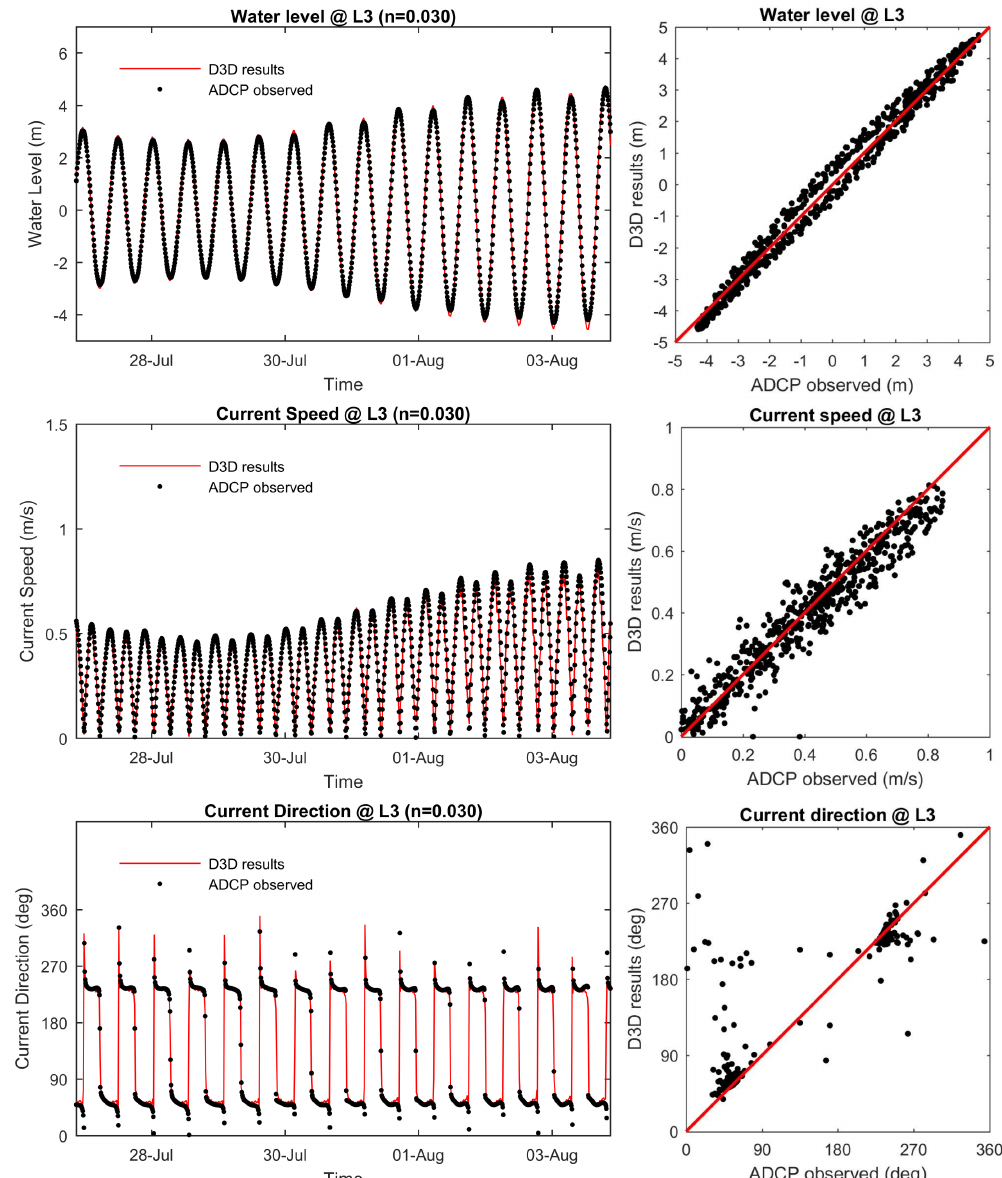
Figure 6. Validation results at location L3, showing time series of water levels and flow velocity ( left ) and scatter plots comparing the observations and simulation results ( right